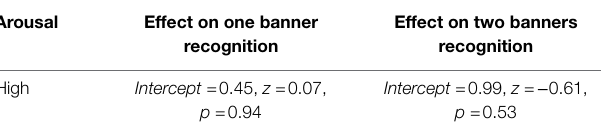
TABLE 5 | Multinomial logistic regression results, where high arousal was chosen as a reference group (Experiment